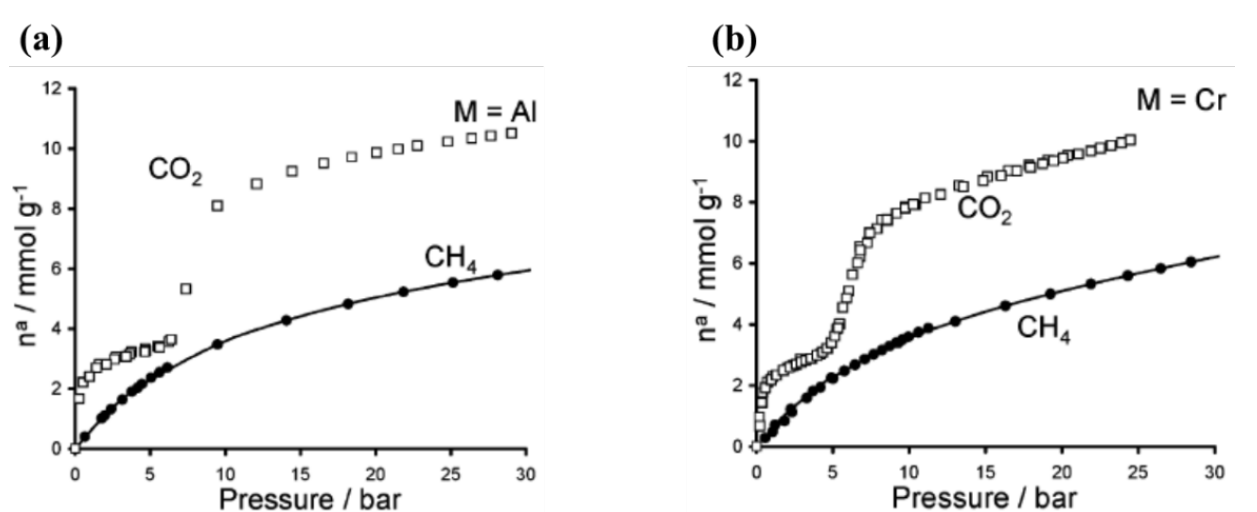
Figure 13. Isotherms at 304 K for the adsorption of CH and ( b ) MIL-53(Cr). Reprinted with permission from [99]. Copyright 2005 American Chemical